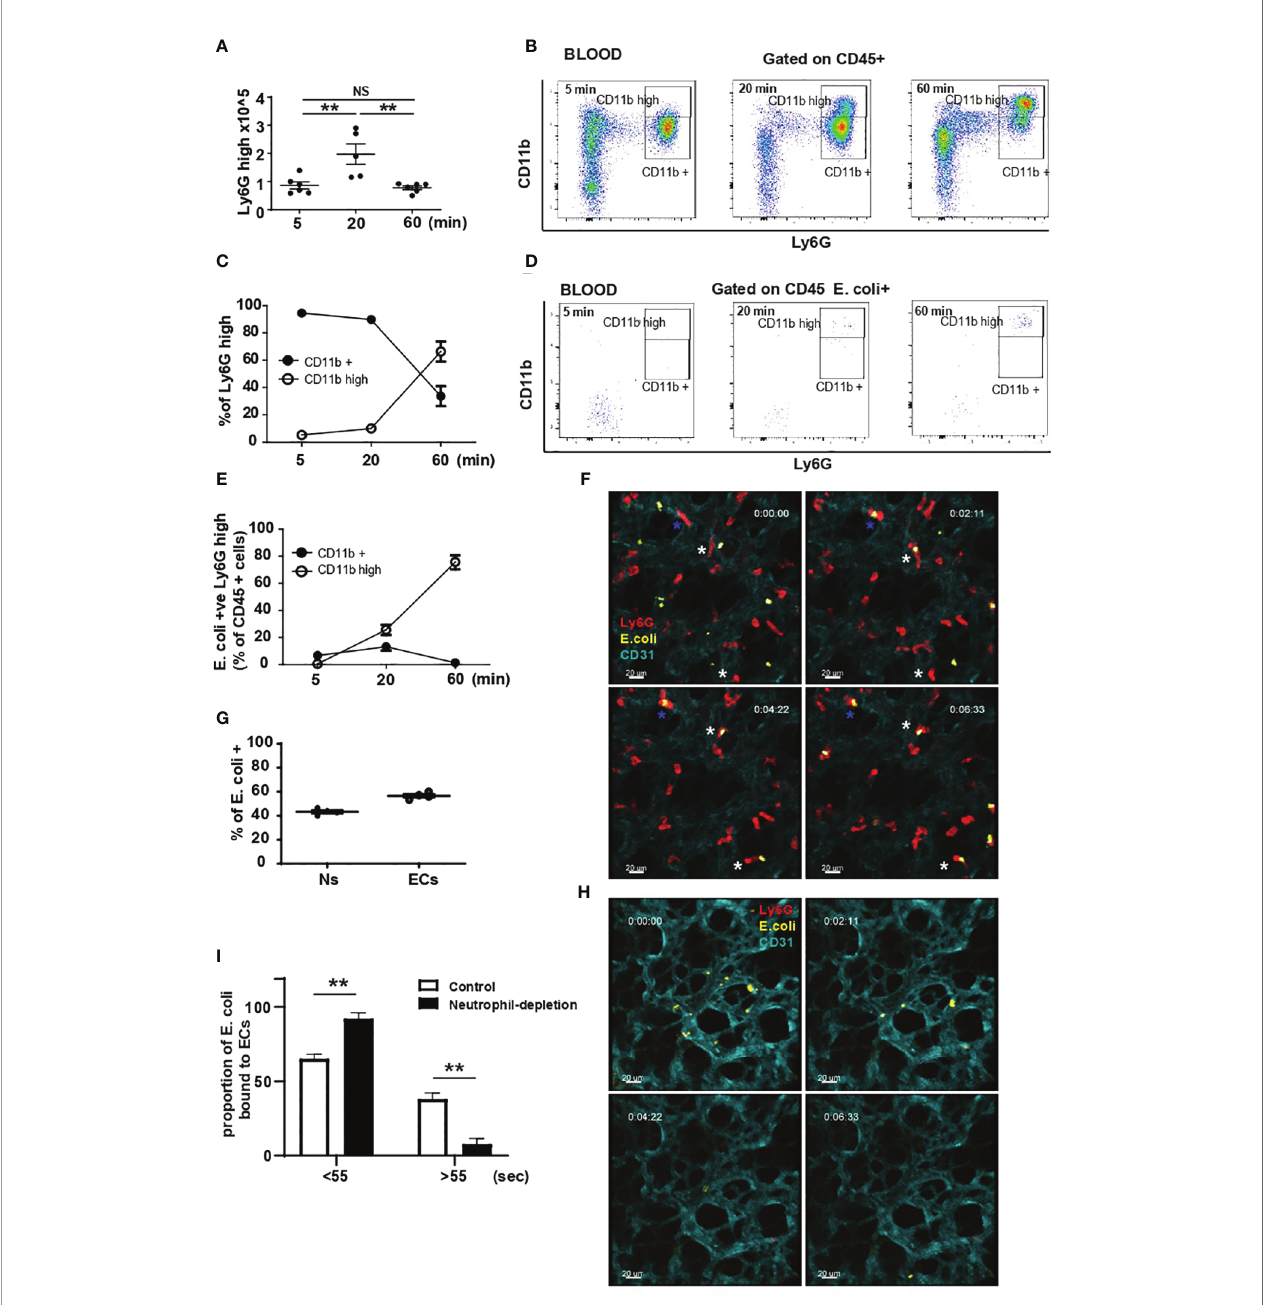
FIGURE 1 | Lung marginated and circulating neutrophils activation and contribution to E. coli capture. (A) Total number of neutrophils by fl ow cytometry 5, 20 and 60 min after i.v. injection of E. coli (N=5-6 mice/timepoint), one-way ANOVA, Tukey ’ s multiple comparison test, three independent experiments. (B) FACS analysis of circulating neutrophils 5, 20 and 60 min after i.v. injection of E. coli , representative of two independent experiments. (C) % of Ly6G high CD11b + and Ly6G high CD11b high neutrophils was calculated 5, 20 and 60 min post i.v. injection of heat-inactivated E. coli , (N=4 mice/timepoint). (D) Flow cytometry analysis of E. coli - positive circulating cells 5, 20 and 60 min after i.v. injection of E. coli , representative of two independent experiments. (E) E. coli -positive Ly6G high CD11b + and Ly6G high CD11b high neutrophils as % of CD45+ cells was calculated 5, 20 and 60 min post i.v. injection of heat-inactivated E. coli , (N=4 mice/timepoint). (F) Sequential frames from video 1, white asterisk shows neutrophil (red) migration toward heat-inactivated E. coli captured by ECs (cyan); blue asterisk shows a neutrophil that captured heat-killed E. coli (yellow) directly from the circulation. Timing represents time from start of imaging. Scale bar 20 m m. (G) Quanti fi cation of EC and neutrophil (Ns) contribution in capturing E. coli from the circulation (N=3 mice). (H) Sequential frames from video 2, showing ECs inability to retain E. coli particles. Timing represents time from start of imaging. Scale bar 20 m m. (I) Proportion of E. coli particles bound to ECs over number of frames in the presence or depletion of neutrophils (N=3 mice/group), one-way ANOVA, Sidak ’ s multiple comparison test, three independent experiments. P < 0.01